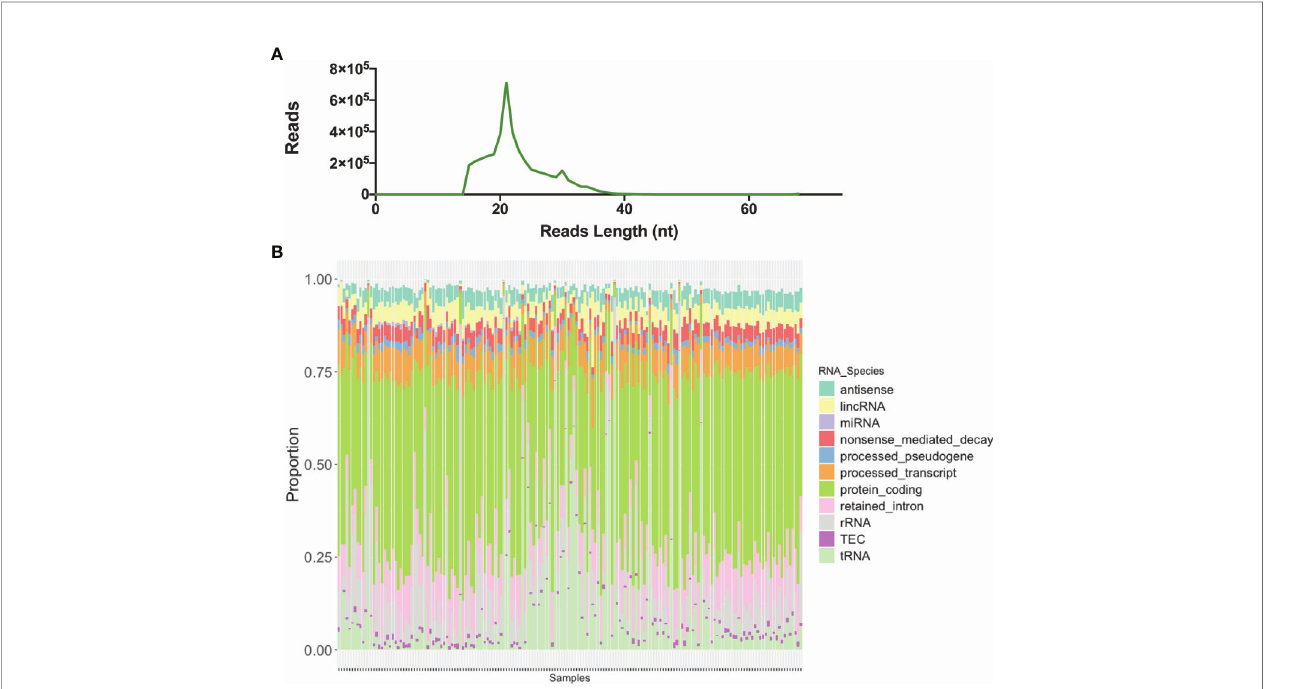
FIGURE 4 | Aligned reads. (A) The average length of the mapped reads across sample are 21 nt in length. (B) The RNA species mapped to the human genome showed predominantly protein coding (green), tRNAs (purple), retained intron (pink), processed transcript (blue), and nonsense-mediated decay RNAs